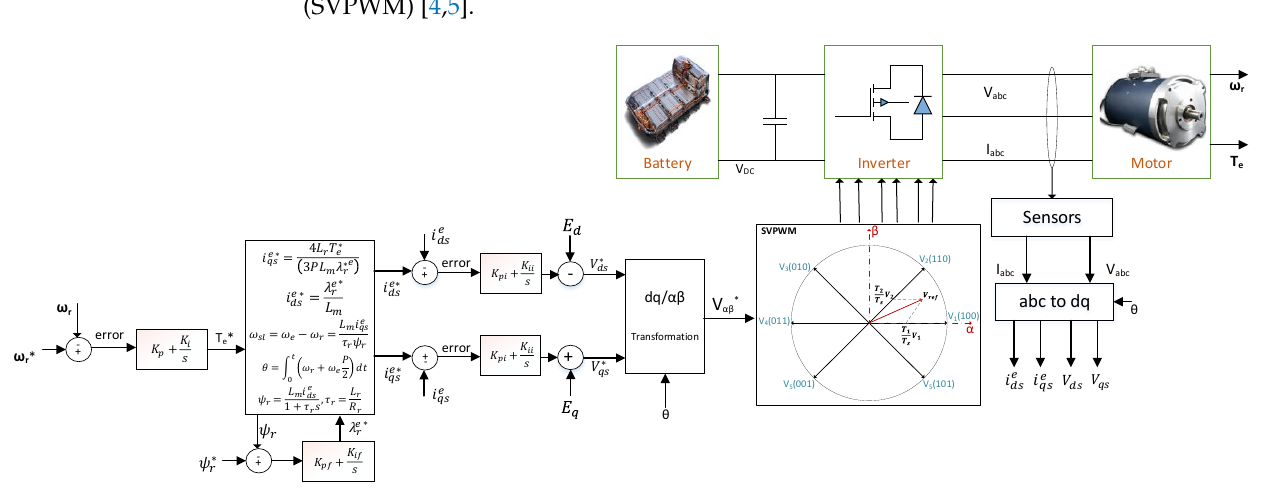
Figure 5. SVPWM-based indirect field-oriented control design (IFOC).